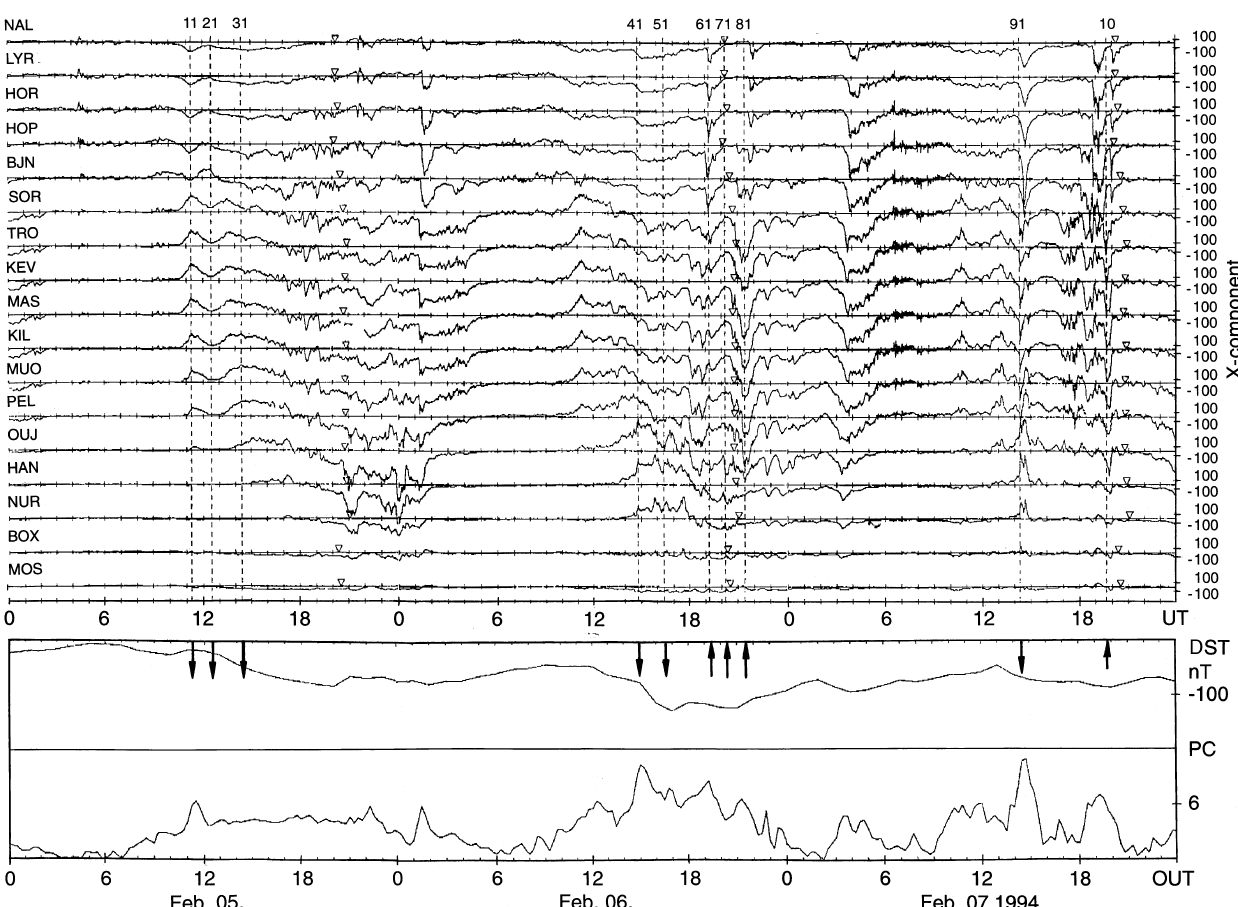
variations for the same storm are shown at the bottom . Arrows directed downwards mark UTs of latitudinal cross section through the eastward electrojet, and arrows directed upwards mark cross sections through the westward electrojet. The location of the magnetic midnight in each station is marked by a